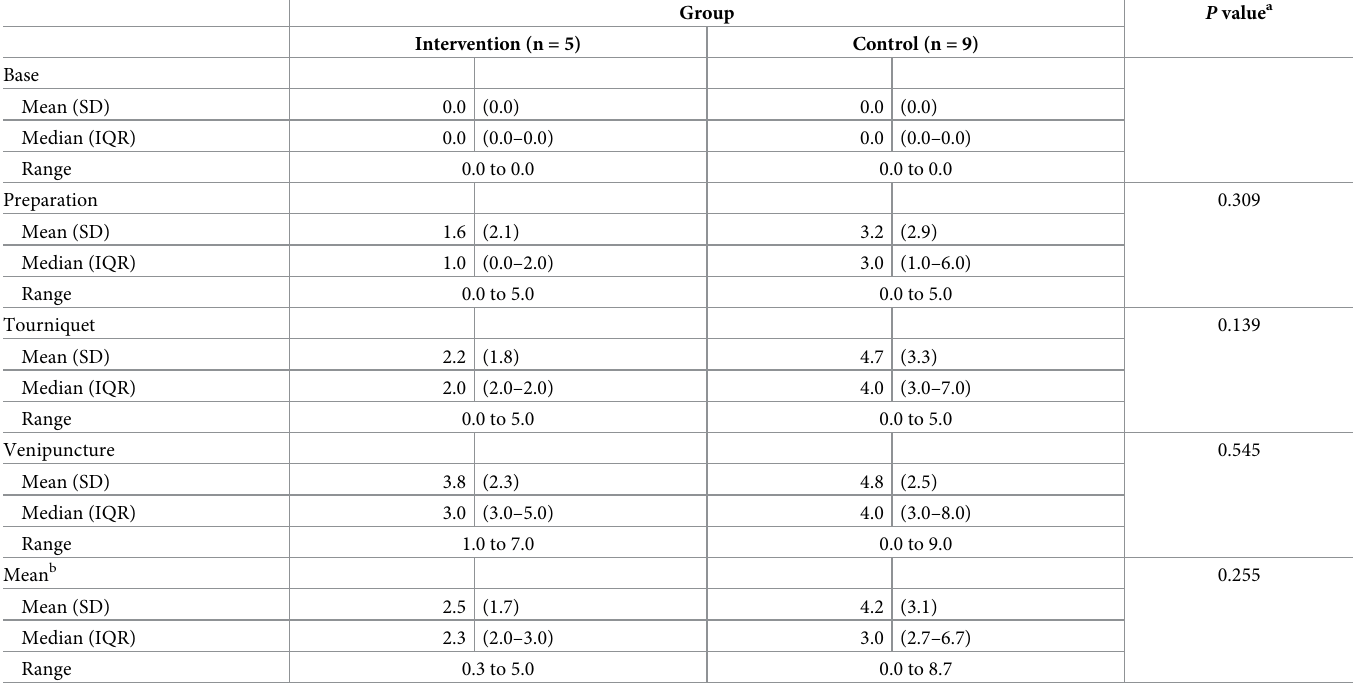
Table 2. Pain assessed using the FLACC scale in the intervention and control